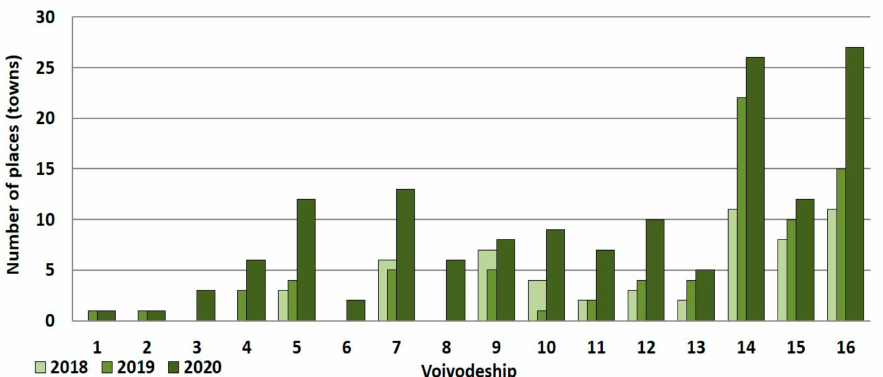
Figure 5. The number of places (towns) where Cydalima perspectalis was recorded in individual voivodships in 2018–2020. Axis X: 1–16—numbers assigned to individual voivodships; see Table 1.